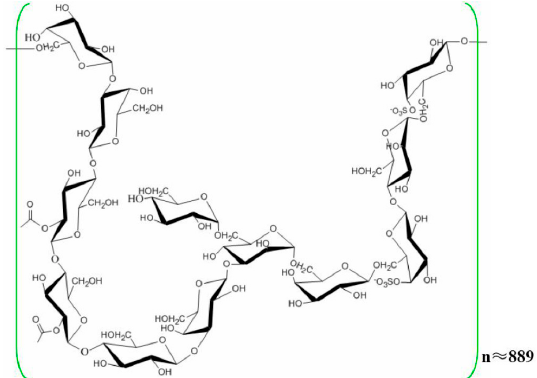
Figure 1. The chemical structure of LJP61A.